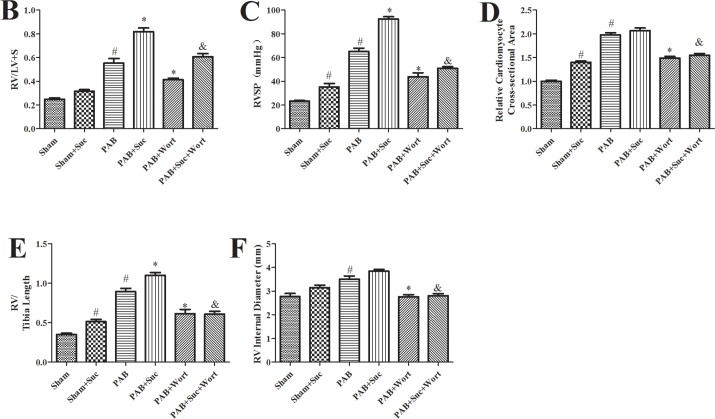
Representative images of HE-stained RV sections and RVH data.A: Representative images of HE-stained RV sections from each group. B: RV hypertrophy indexed by the ratio of the wet weight of the RV to the left ventricular wall plus the septum [RV/(LV+S)] in each group (n = 8). C: RV systolic pressure in each group rats (n = 8). D: The relative cardio myocyte cross-sectional area in each group (n = 8). E: The RV/tibia length in each group (n = 8); #P<0.05 compared to the sham group; *P<0.05 compared to the PAB group. F: Representative images of Masson-stained pulmonary sections from Sham, PAB and PAB+Suc groups.